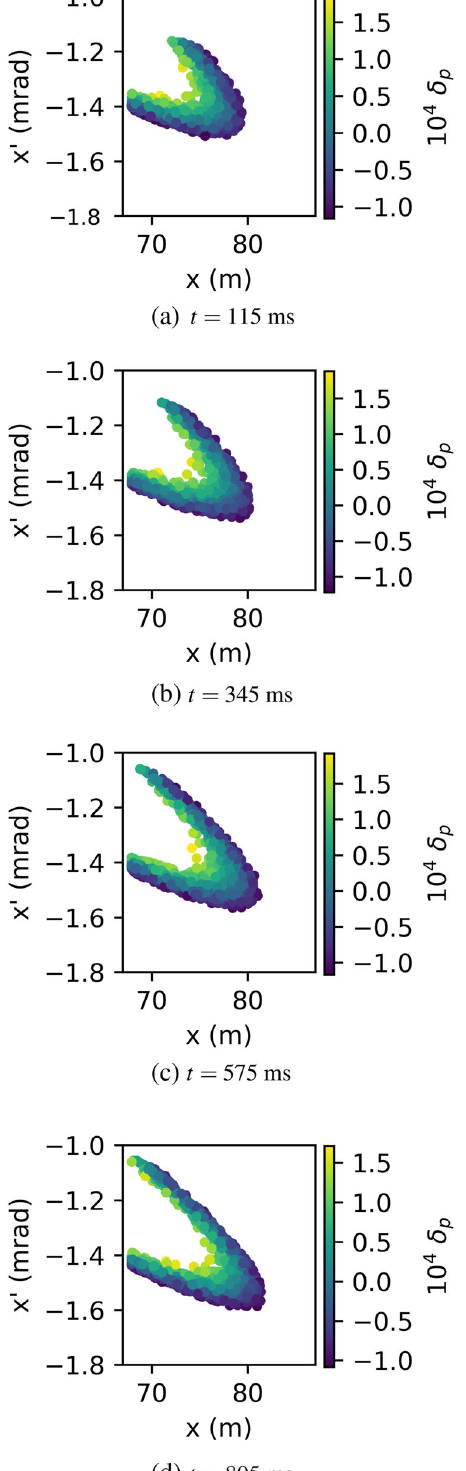
FIG. 3. Q -sweep ( time dependent ): instantaneous phase space presentation to the high-field side of the ZS in the presence of octupole fields simulated during a short spill on a 1.2 s flat-top.